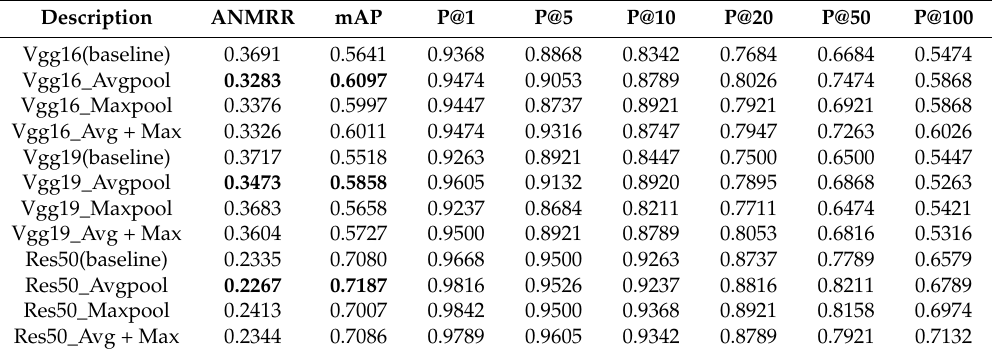
Table 1. Comparisons of different attention modules by using different pooling methods. The best result for each baseline CNN (Convolutional Neural Network) is reported in bold.